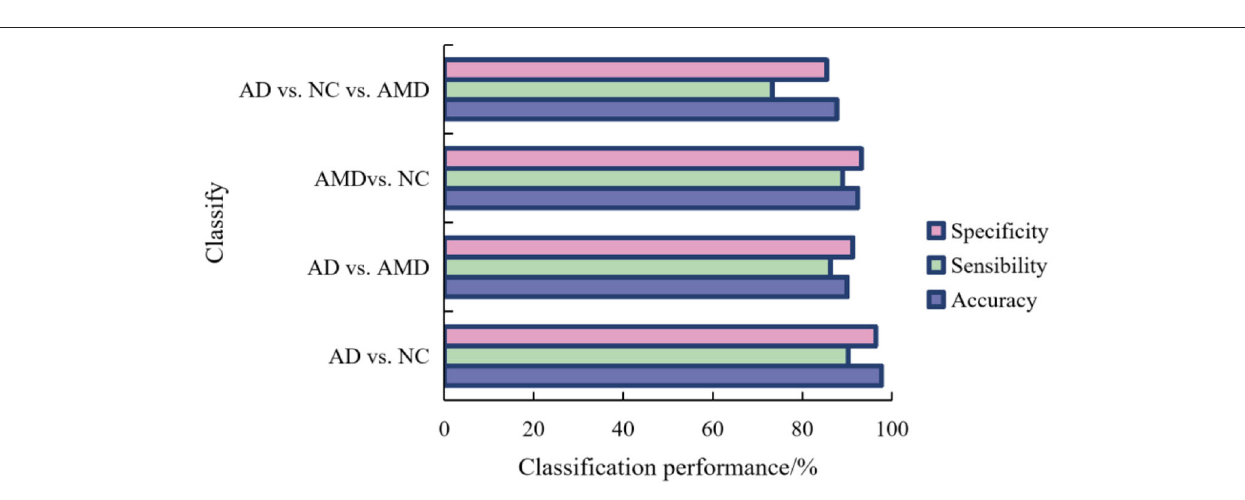
FIGURE 7 | PerformaNCe of ResNet-20_TL model in AD, NC, and AMD